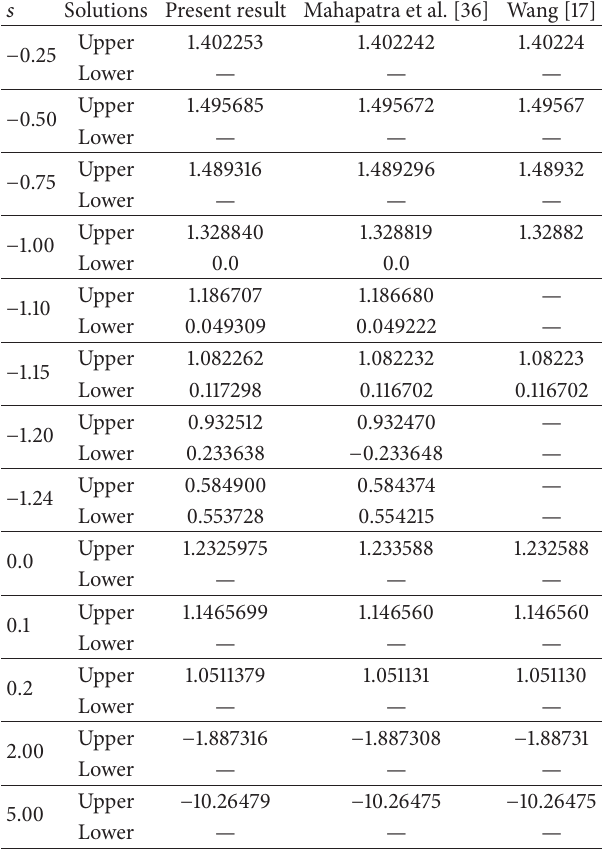
Table 1: Comparison of the values of skin friction 𝑓 󸀠󸀠 (0) for 𝛾 = 0 , 𝜆 = 0 , and 𝑀 = 0 .